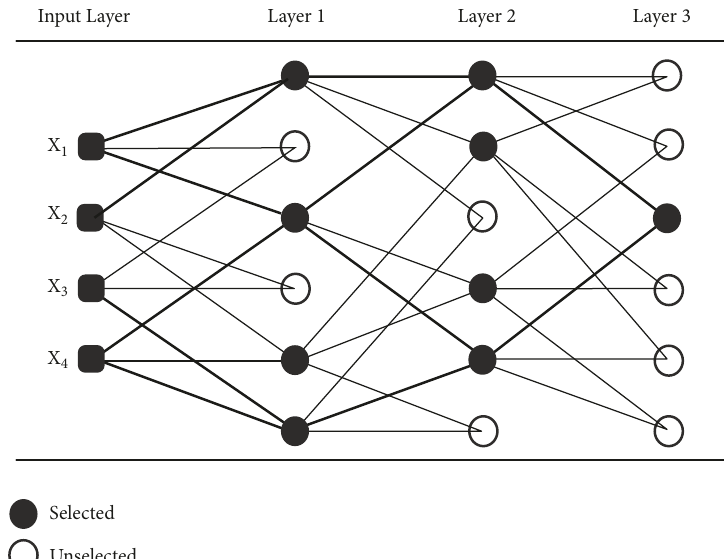
Figure 2: Architecture of GMDH-type neural network (NN) algorithms.